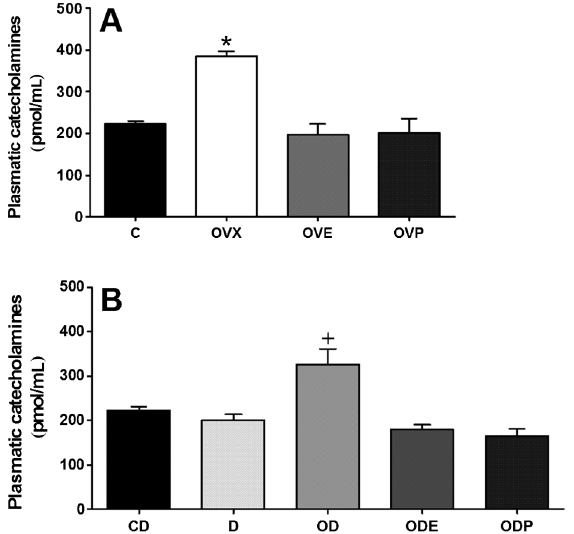
Figure 2. Plasma catecholamine levels in female rats. A , Control (C), ovariectomized (OVX), OVX with 17 b -estradiol benzoate (OVE, 2.0 mg ? kg -1 ? day -1 , sc ), and OVX with progesterone (OVP, 1.7 mg ? kg -1 ? day -1 , sc ), both for 7 days. B , Sham-denervated (CD), denervated (D), D ovariectomized (OD), OD with 17 b - estradiol benzoate (ODE), and OD with progesterone (ODP), both for 7 days. Data are reported as means±SE (n=8). *P , 0.01 and + P , 0.01 compared to C and CD, respectively (ANOVA and Tukey